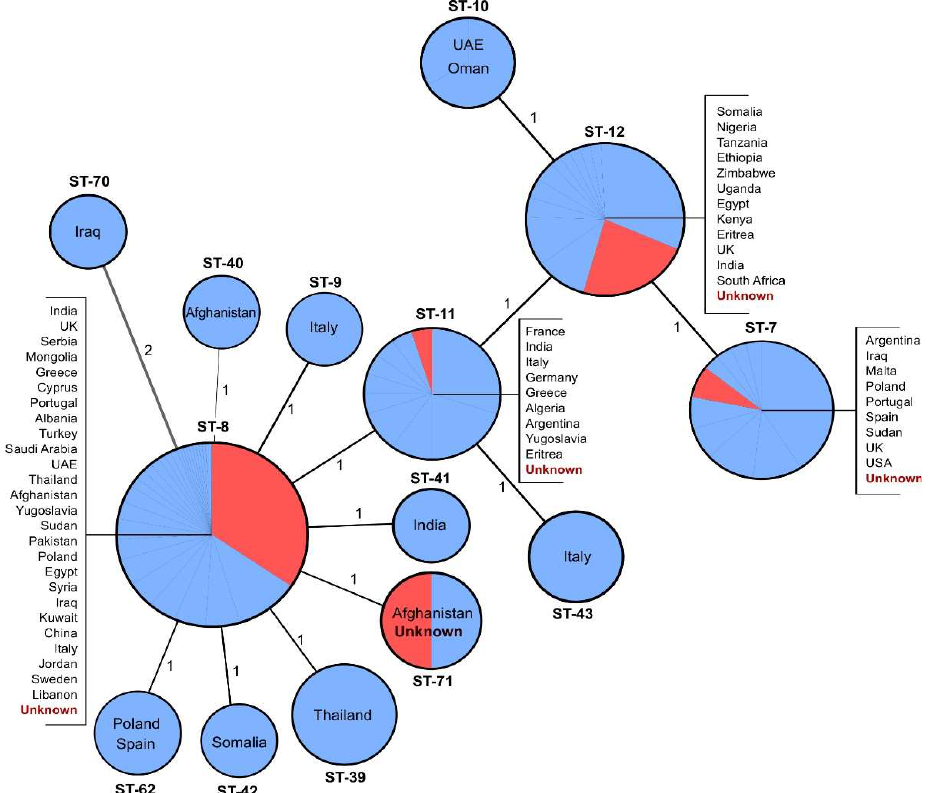
Figure 1. Minimum spanning tree of B. melitensis isolates typed by multilocus sequence typing (MLST-9). Published MLST-9 profiles ( n = 179) downloaded from the PubMLST Database (https://pubmlst.org/brucella/) and profiles of the strains from this study ( n = 103) were used to generate the tree using the goeBURST algorithm in PHYLOViZ software. Each node corresponds to a sequence type (ST), and the branches are labeled with the number of discriminating loci. Swedish isolates obtained from patients with unknown travel history are represented in red.